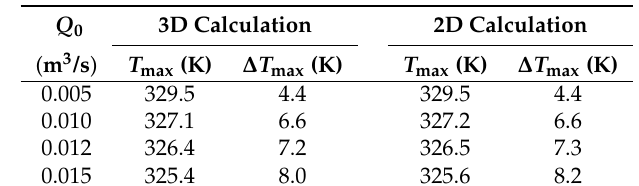
Table 2. Comparison of numerical results at the end of the five-current (5C) discharge process by 2D calculation and 3D calculation.